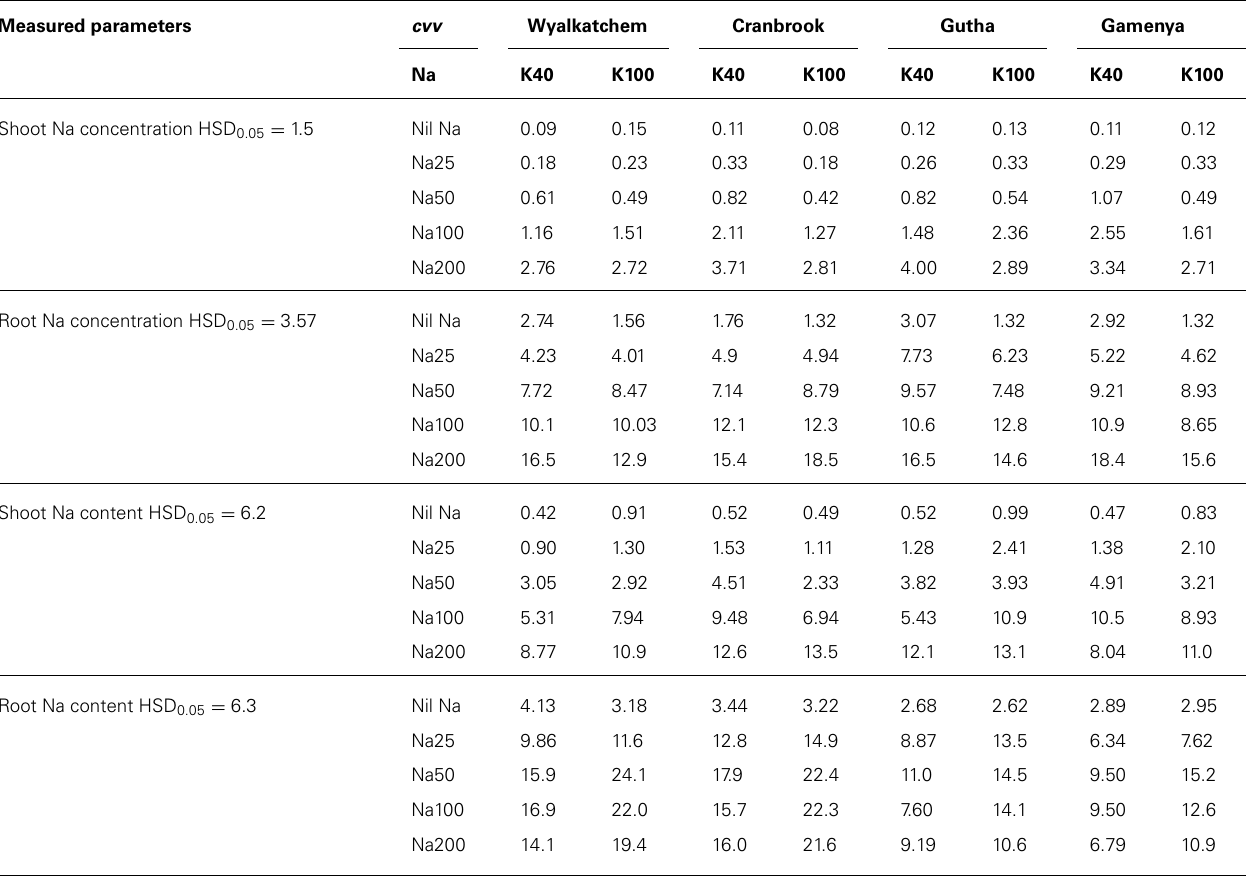
Table 3 | Shoot and root Na concentrations (mg/g, dry weight) and contents (mg/plant) of four wheat cultivars treated with two K levels (40, 100 mg K/kg) and five Na levels (0, 25, 50, 100, 200 mg Na/kg) for 8 weeks ( n = 3). Measured parameters